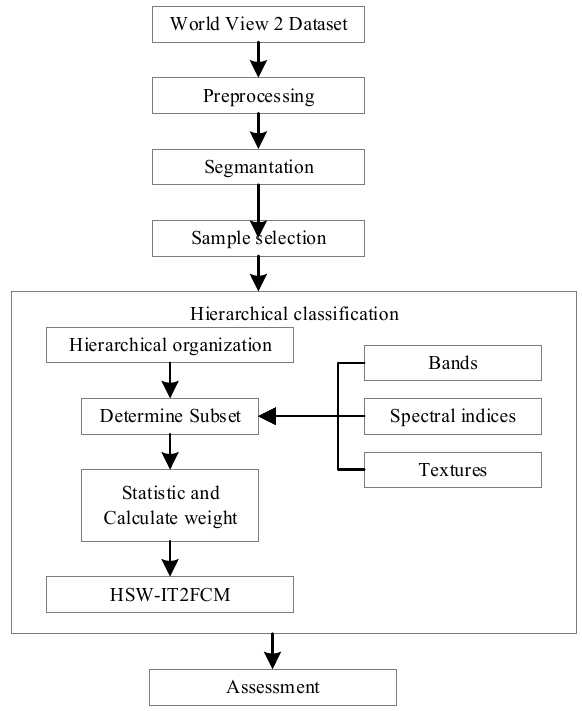
Figure 3. Diagram of the technical approach of this paper.